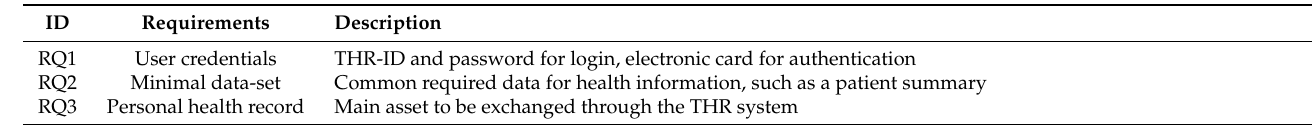
Table 4. Requirements for the THR